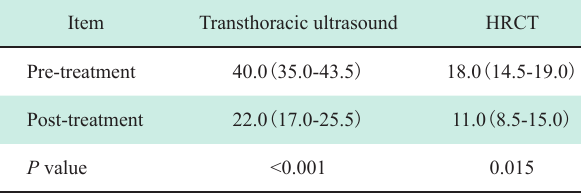
Data are Median (IQR). HRCT, high resolution computed tomography.